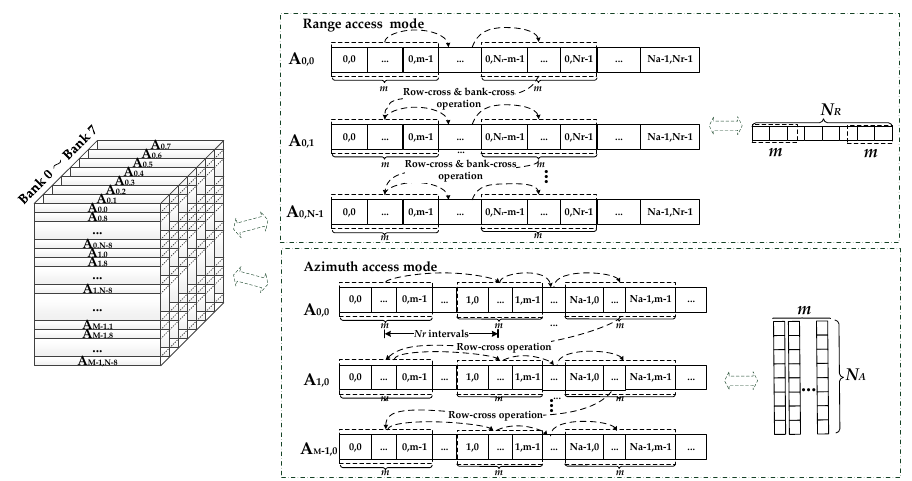
Figure 9. Range and azimuth access modes of the DDR SDRAM.